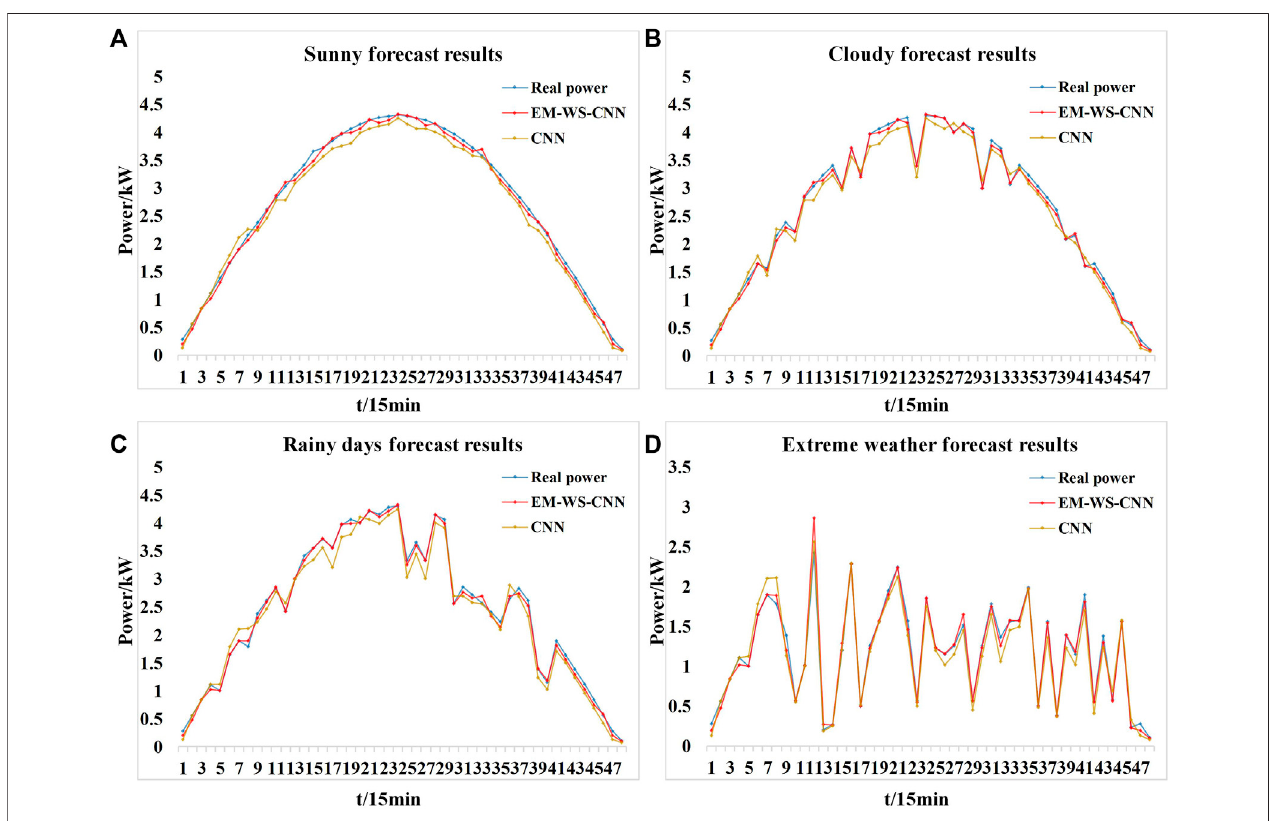
FIGURE 5 | Predict results for different weather types.